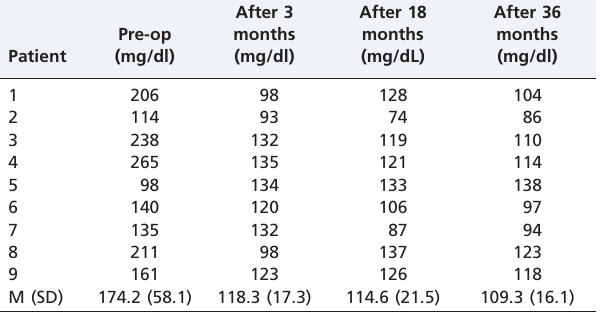
Table 2 - Fasting glycemia: Comparison between preoperative values and values at 3, 18, and 36 months after surgery. All postoperative values were significantly lower ( p , 0.05). M = mean; (SD)= standard deviation.